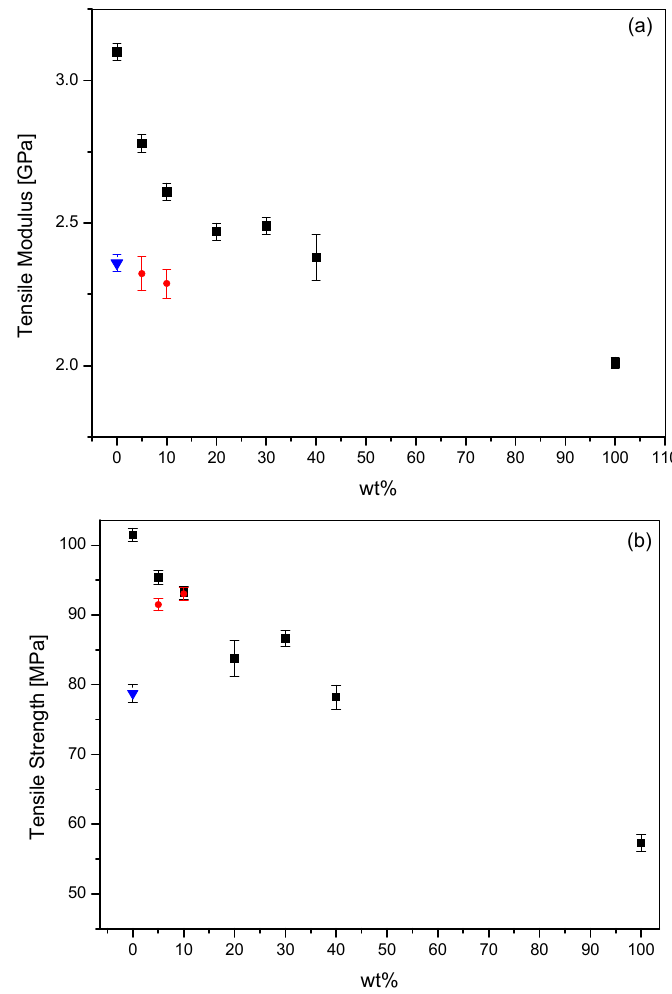
Figure 14. Effect of modifier content for PEI/PC (black) and PEI/PETG (red) blends compared to Ultem 9085 (blue) on tensile modulus ( a ) and tensile strength ( b ).